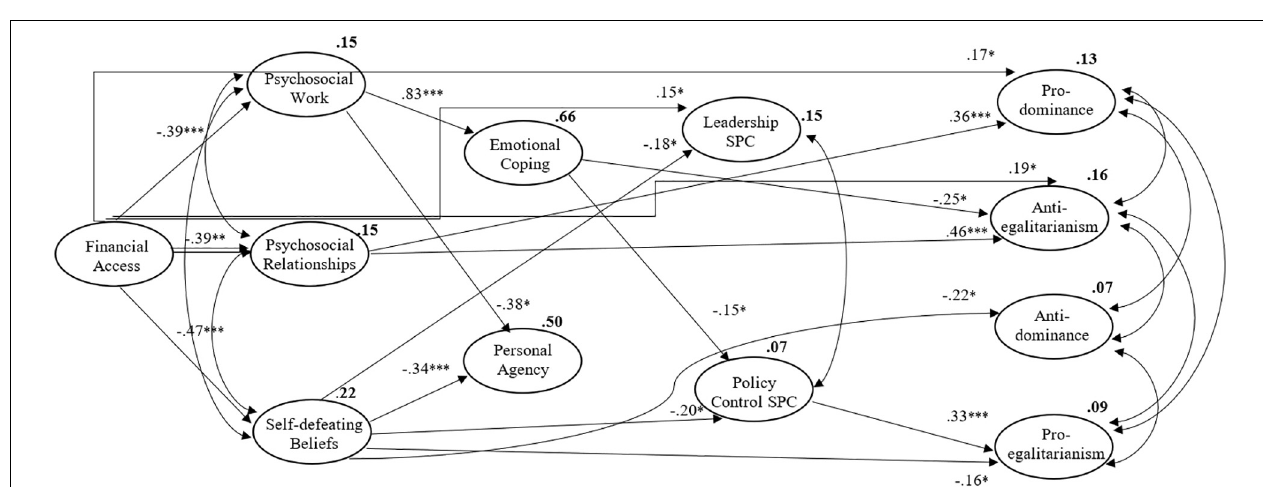
FIGURE 2 | Model A, representing significant effects; ∗∗∗ p < 0.001; ∗∗ p < 0.005; ∗ p <